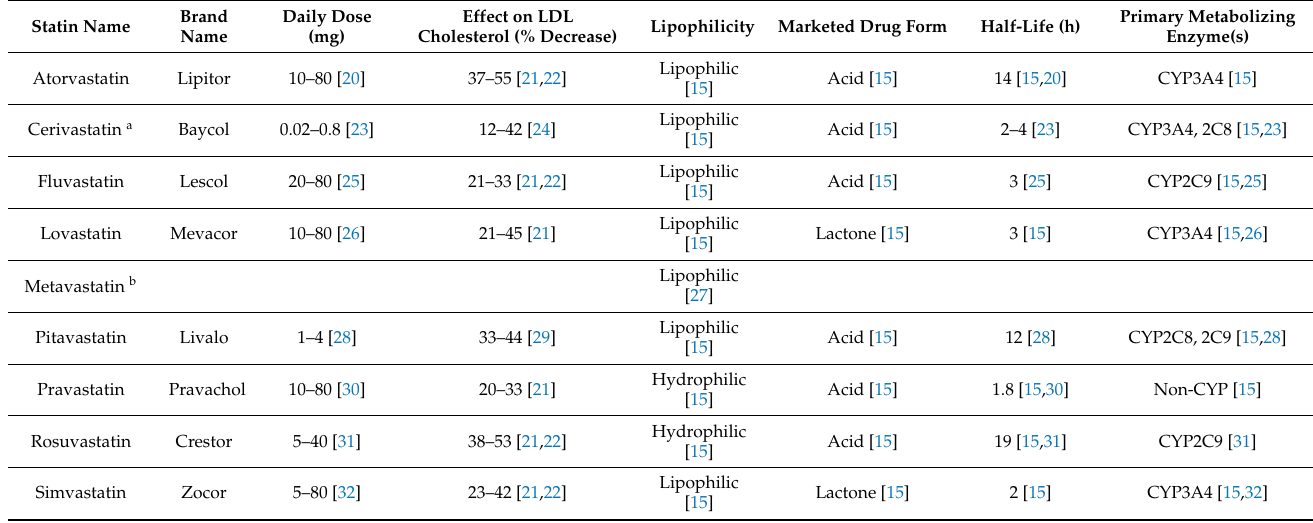
Table 1. Pharmacokinetic properties of different